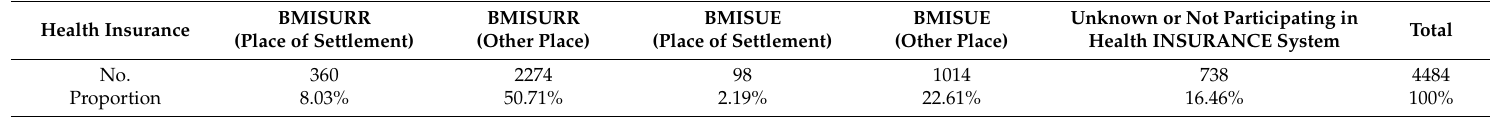
Table 2. Sample distribution of health insurance participation of senior floating population of China. BMISURR, Basic Medical Insurance System for Urban and Rural Residents; BMISUE, Basic Medical Insurance System for Urban Employees.